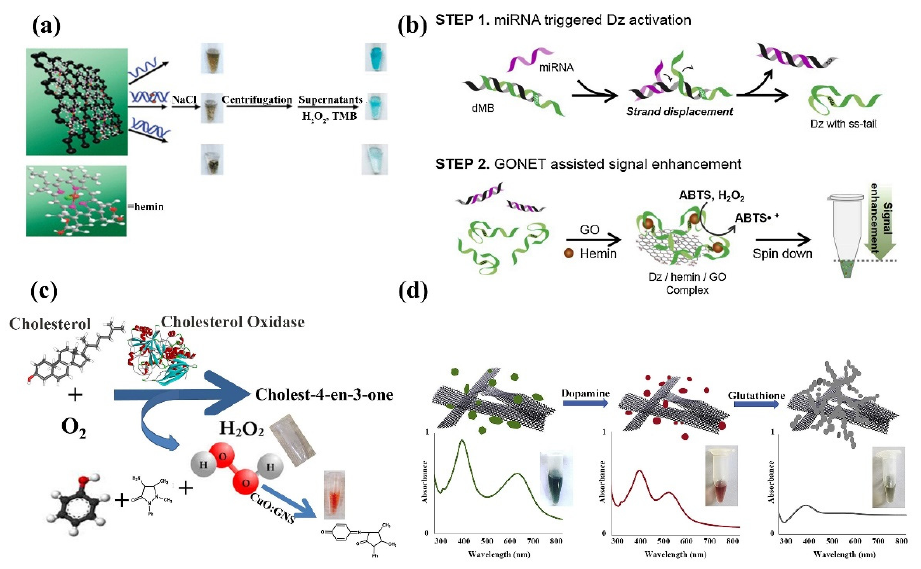
Figure 14. ( a ) Label-free colorimetric detection system for the detection of single nucleotide polymorphisms (SNPs) in disease-associated DNA. From top to bottom, they are ssDNA, single misaligned double-stranded DNA and complementary double-stranded DNA. Reprinted with permission from Ref. [186]. Copyright 2011, American Chemical Society. ( b ) Schematic diagram of GONET-based advanced colorimetric miRNA detection. Reprinted with permission from Ref. [187]. Copyright 2019, Elsevier. ( c ) Schematic diagram of the process of cholesterol detection by colorimetric method. Reprinted with permission from Ref. [188]. Copyright 2017, Elsevier. ( d ) Colorimetric sensors based on graphene/silver hybrid materials for the detection of dopamine (DA) and GSH. Reprinted with permission from Ref. [189]. Copyright 2020, Elsevier.